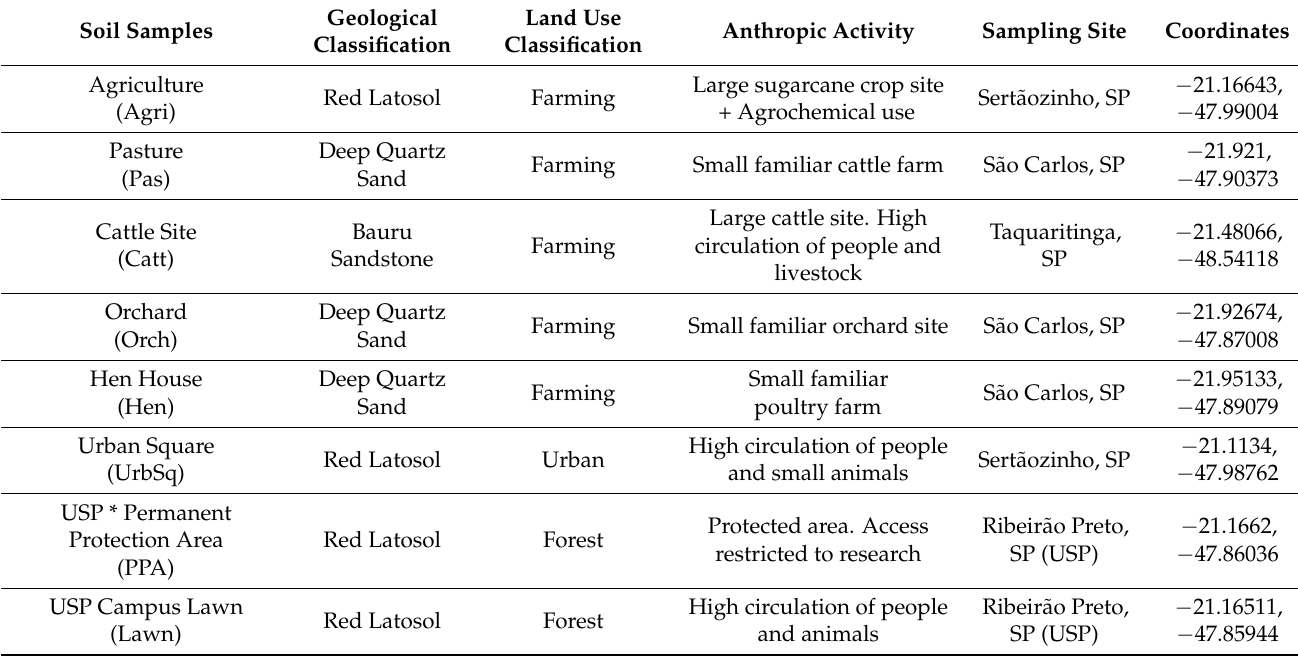
Table 1. Main characteristics and soil sample